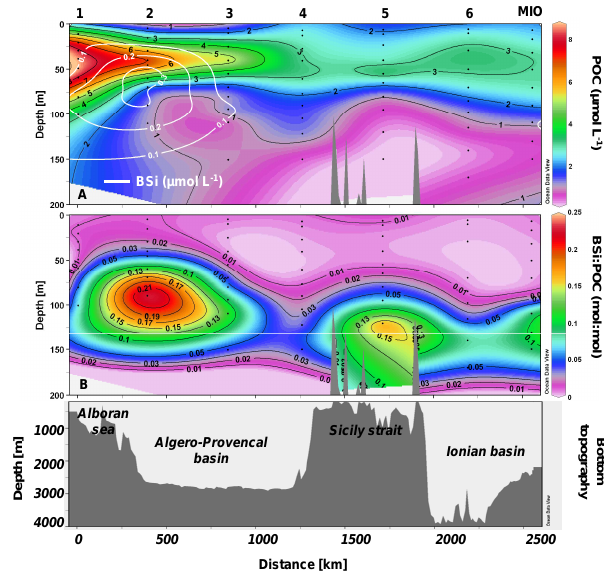
Fig. 7. (A) Distribution of particulate organic carbon (POC) (µmolL − 1 ) , with BSi concentrations (µmolL − 1 ) isopleths as over- lays in white and (B) BSi:POC ratios (mol:mol) along transect 1 during the PROSOPE cruise (summer/fall 1999).